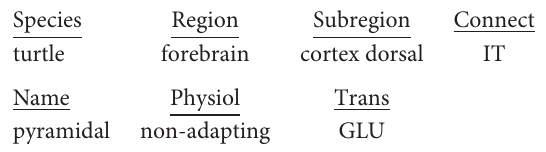
FIGURE 4 | Basic pyramidal cell (principal cell) circuit modules of the piriform (olfactory) cortex. Red indicates excitatory neurons, blue indicates inhibitory neurons. SL, semilunar pyramidal cell; sPC, superficial pyramidal cell; dPC, deep pyramidal cell [Adapted from Shepherd and Rowe